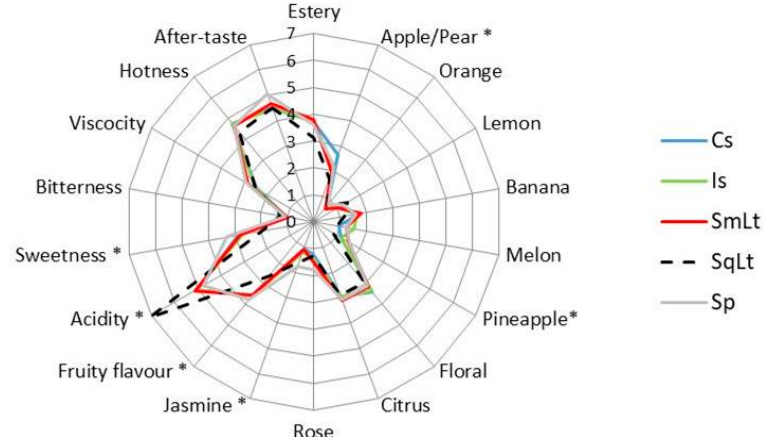
Figure 6. Sensory attributes scores for the wines produced through different inoculation schemes.